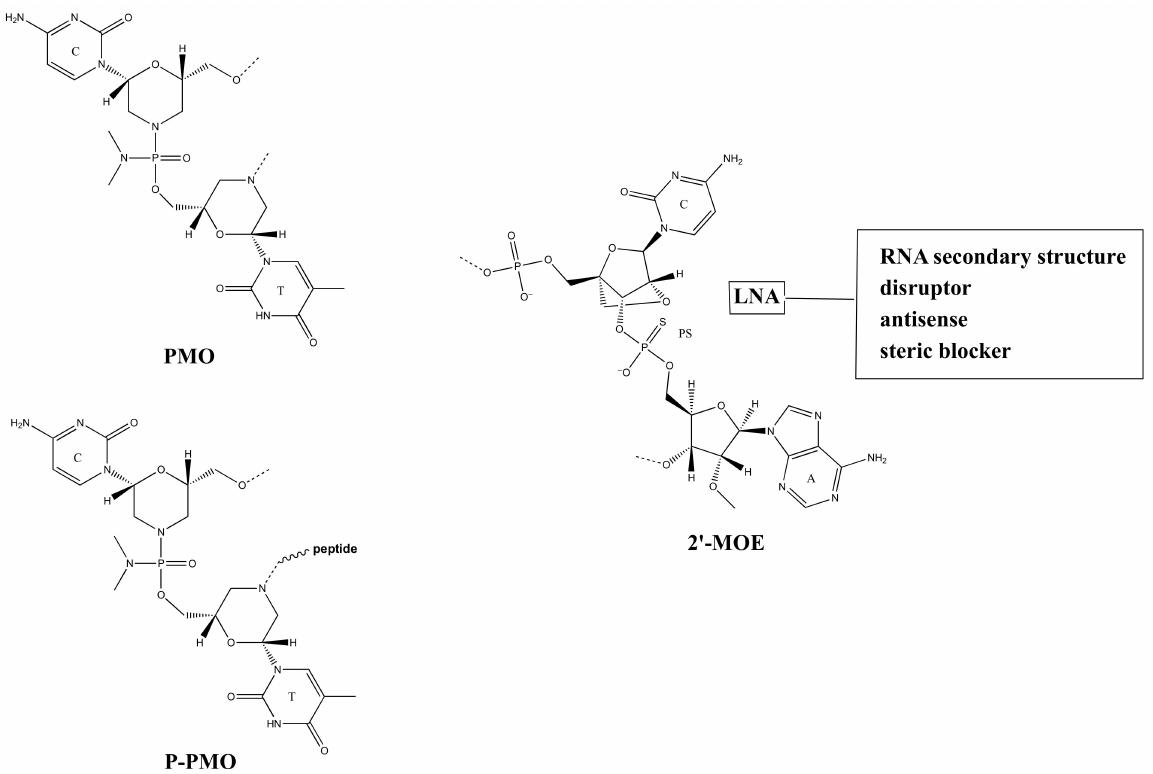
Figure 5. Structures of nucleic acid analog [PMO (morpholino), P-PMO (peptide-morpholino), LNA (locked nucleic acid)] moieties and modifications of the nucleic acid backbone [PS (phosphorothioate), 2 (cid:48) -MOE (2 (cid:48) -methyl O-ester)] employed in the antisense strategies against SARS-CoV-2. Further investigations used antisense oligonucleotides carrying 2 (cid:48) - O -methoxyethyl (2 (cid:48) -MOE, Figure 5) and phosphorothioate (PS, Figure 5) backbone modifications as steric blockers to disrupt interactions between the host RNA binding proteins and SARS-CoV-2 antisense oligonucleotides, carrying LNA tracts at both ends, were used to target the SARS-CoV-2 stem-loop 2 motif (s2m) in the 3 (cid:48) -UTR of the cytosolic positive-sense